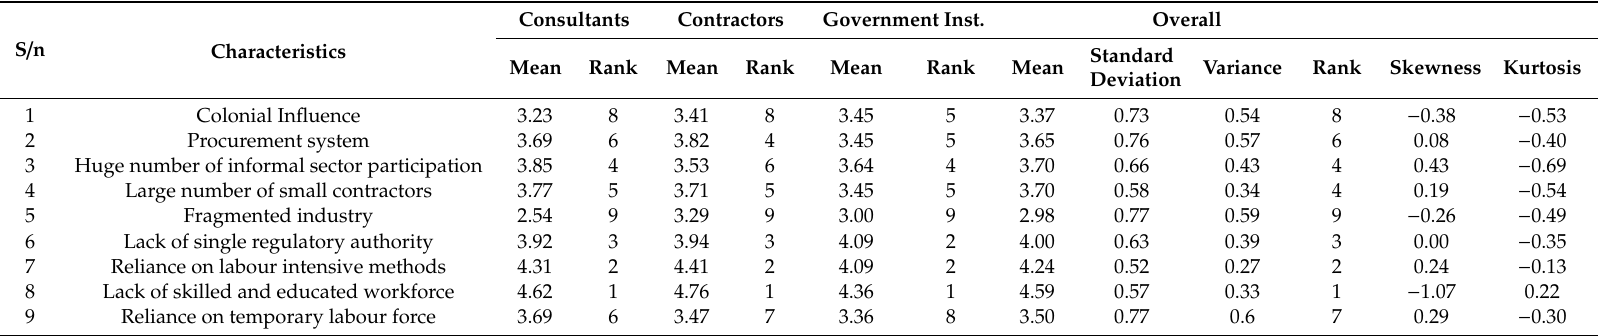
Reliance on temporary labour